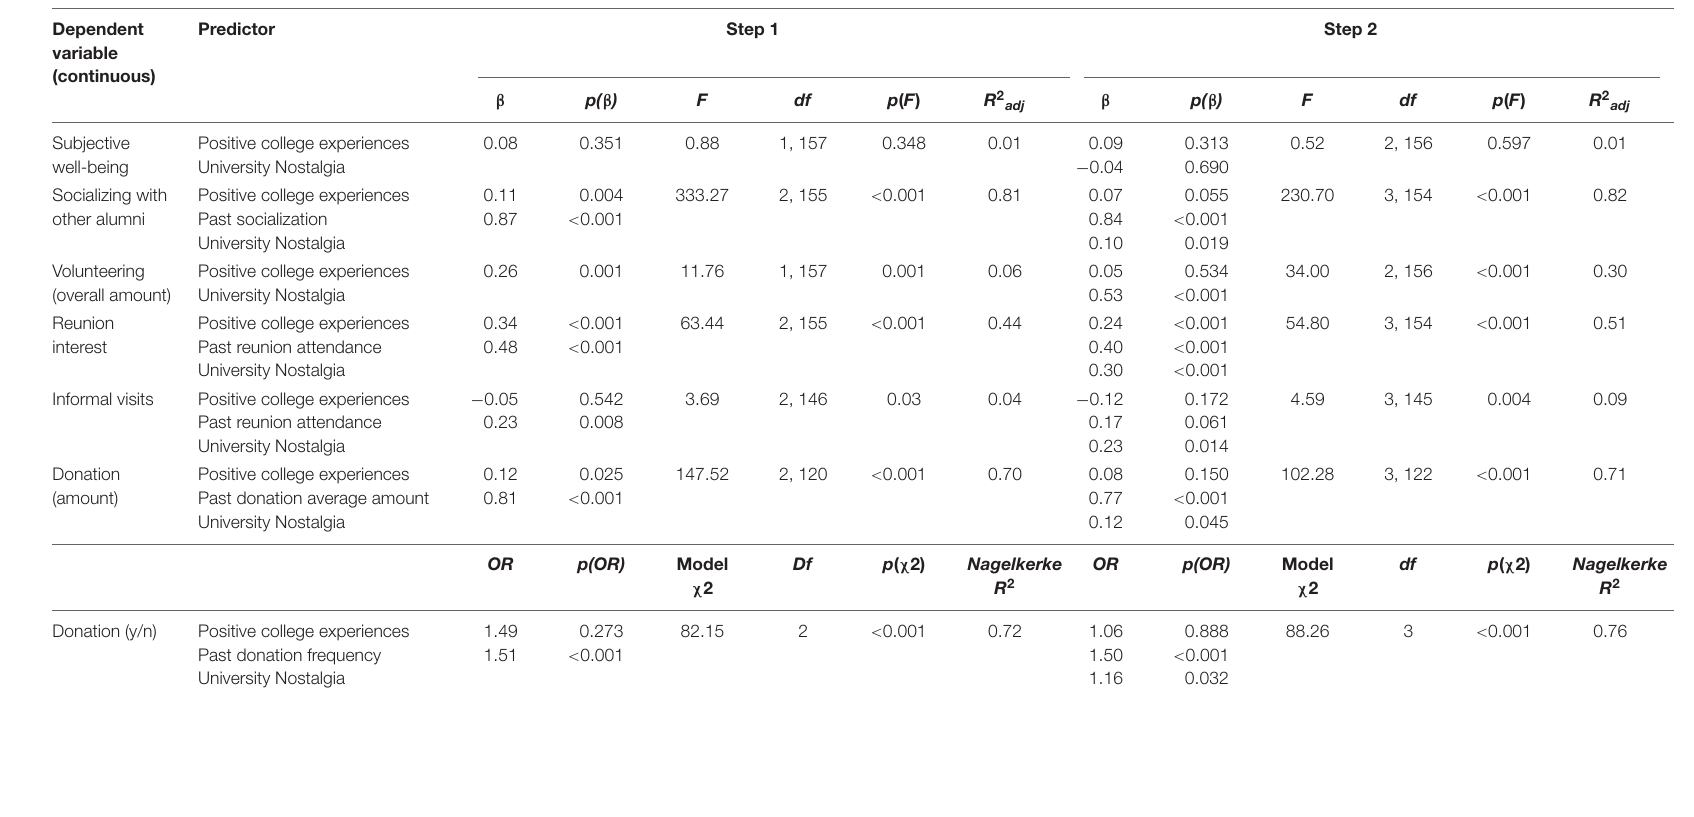
TABLE 6 | Regression models for study 2 well-being and alumni engagement